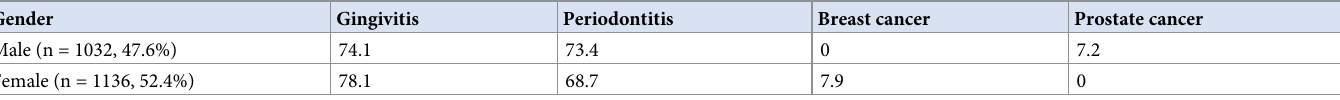
Table 1. Prevalences in percent of the 2168 men and women who had the cancer diagnoses breast cancer and prostate cancer and the periodontal inflammation gin- givitis and periodontitis. Gender Gingivitis Periodontitis Breast cancer Prostate cancer Male (n = 1032,